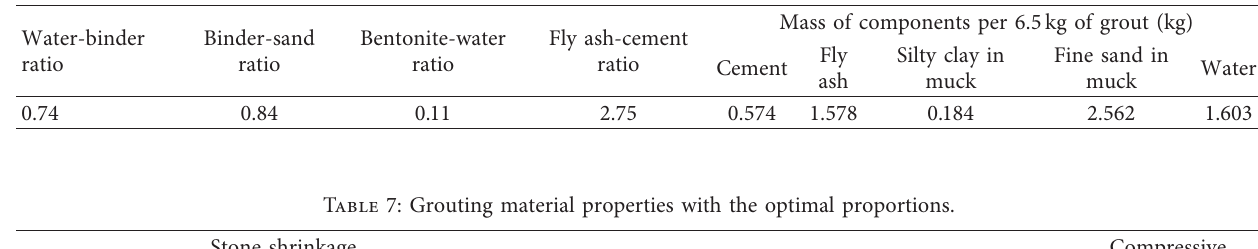
Table 6: Optimal proportions of synchronous grouting material prepared from shield muck.